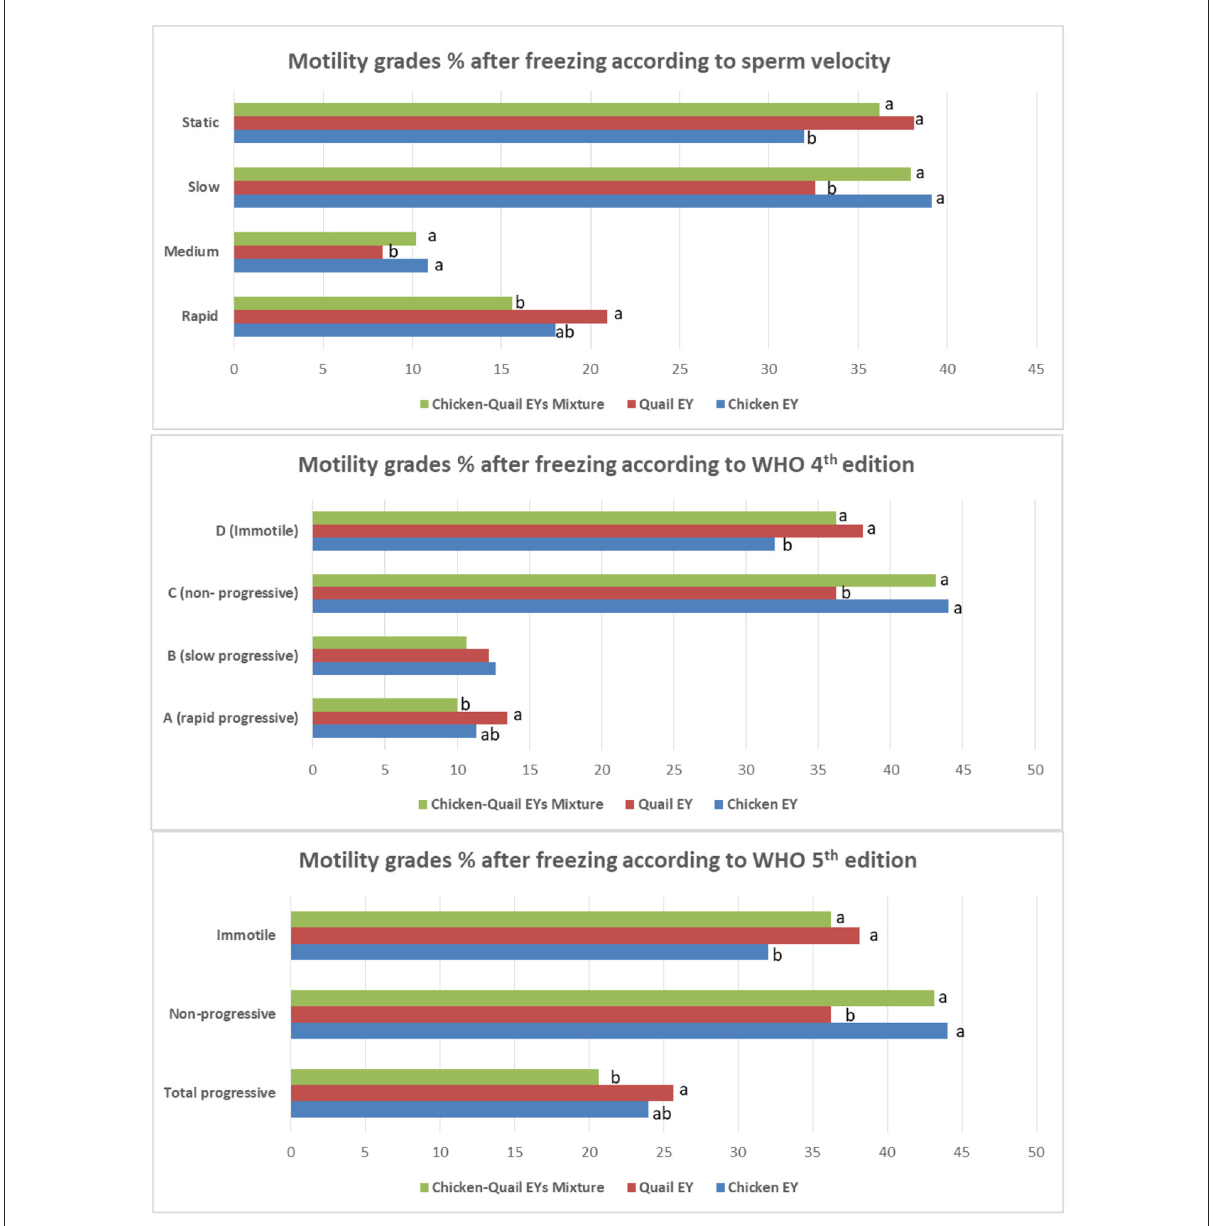
FIGURE4 Effects of adding and combining egg yolks (EY) of chicken and/or quail to the Tris glycerol extender on motility grades of ram sperm post-thawing. a,b,c, different letters indicate significant differences among the different egg yolks for each evaluated parameter; Progressive motility, Percentage of sperm presenting movement with a STR index ≥ 80% within the sample; Statics, VCL < 10 µ m/s; Slow, 10 < VCL < 45 µ m/s; Medium, 45 < VCL < 75 µ m/s; Rapid, VCL > 75 µ m/s. In WHO 4th edition, the more details of progressive motility were added including slow or rapid progressive. While, in WHO 5th edition, the total progressive motility was presented as a one category regardless sperm velocity.